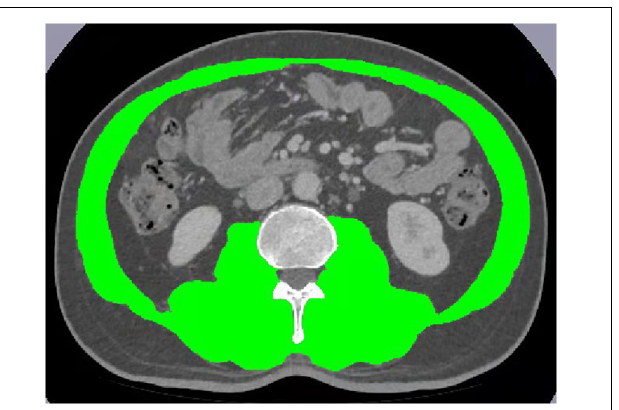
FIGURE 2 | Skeletal muscle mass analysis of computed tomography images on an L3 section by